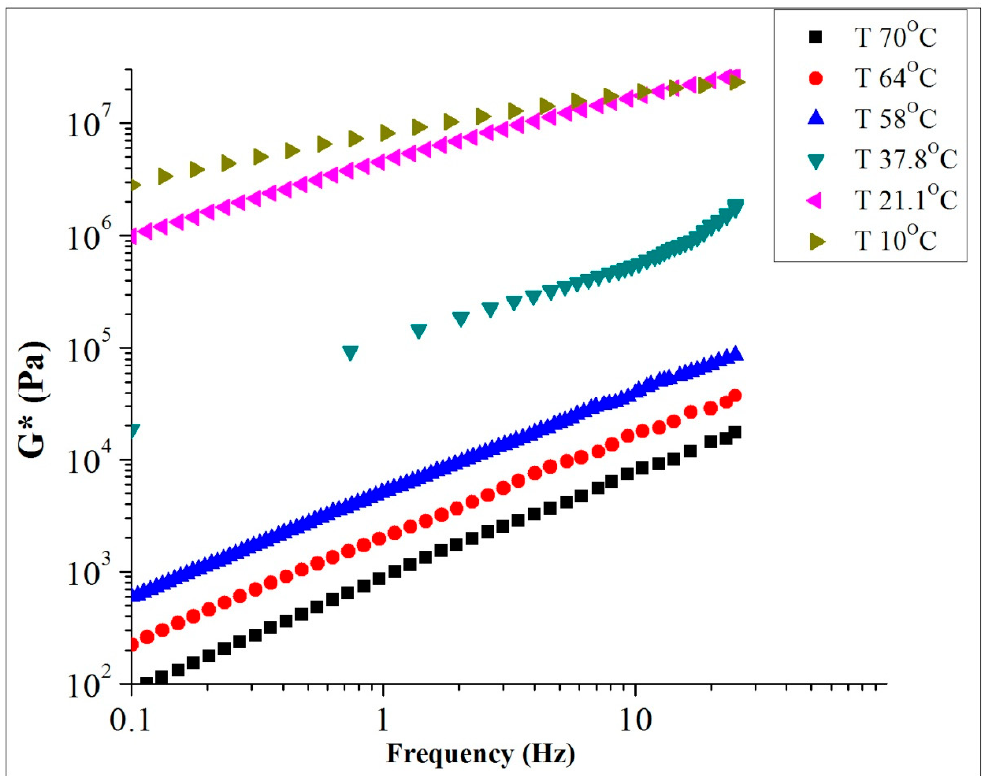
Figure 7. Log Isothermal plot of MMB20.